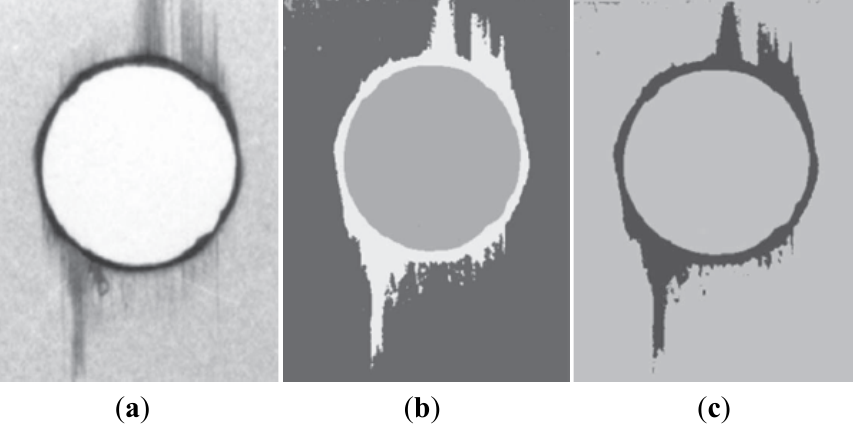
Figure 7. Pipeline of the computational processing of a radiographic image: ( a ) original image; ( b ) image segmented by using a neuronal network; ( c ) identification of the delamination